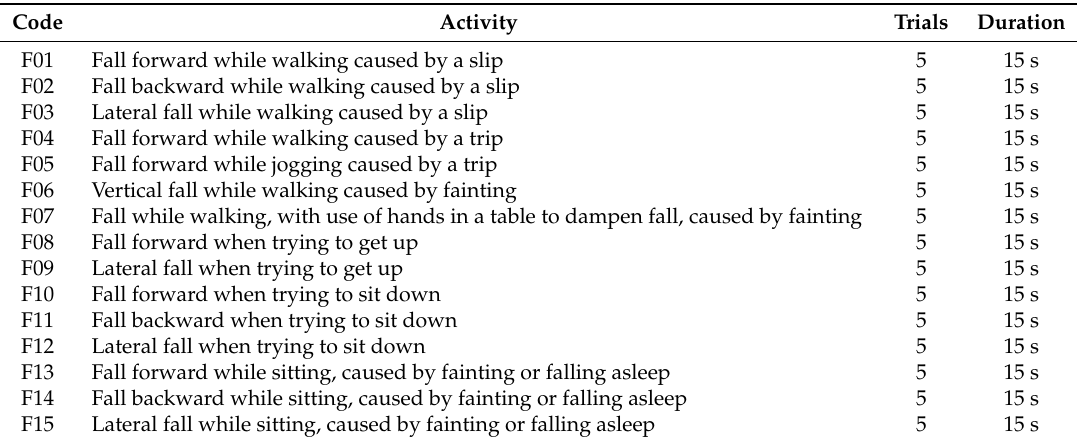
Table 1. Types of falls selected for this work.